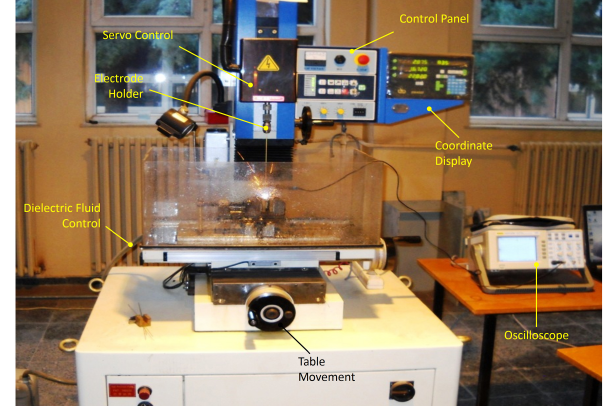
Figure 3. Hole drilling EDM machine with experimental